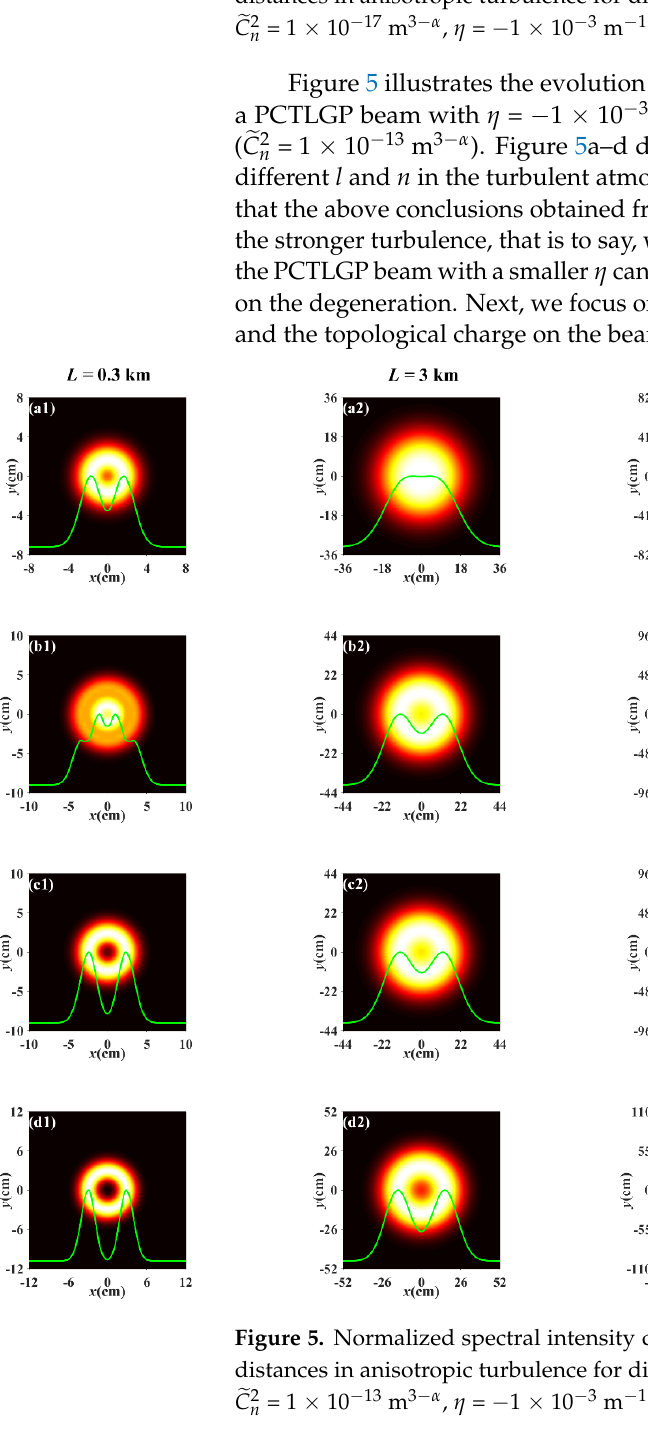
Figure 4. Normalized spectral intensity distribution of the PCTLGP beam at several propagation distances in anisotropic turbulence for different mode orders and topological charges ( ξ x = ξ y = 3, C ̃ 2